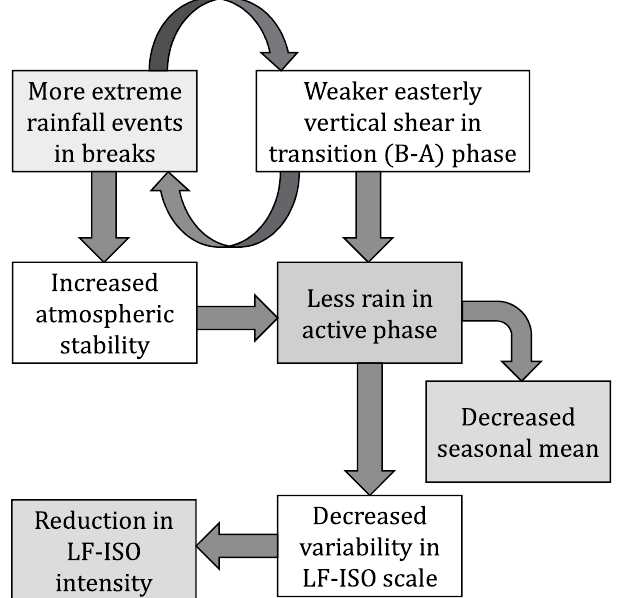
Figure 4. Mechanism in a flowchart. Flowchart for the mechanism of the decrease in seasonal mean and low- frequency intraseasonal variability strength over India. Increased extreme rainfall events in the break phases weakens the easterly vertical shear over the northern Indian region. This weakens the instability over the region, causing the lesser convective activity in subsequent active phase. This fact is supported by the the fact that the stability over CI has increased when we have more extreme events, especially during breaks. Weaker vertical shear creates favourable conditions for the growth of deep convective storms, providing a feedback in process. Since majority of the seasonal mean rainfall occurs during the active phase, this decrease in active phase rainfall decreases the seasonal mean. Reduction in active phase rainfall also incapacitates variability in low- frequency intraseasonal scale, which in turn, weakens the LF-ISO intensity. Figure is generated using Microsoft Powerpoint 2010